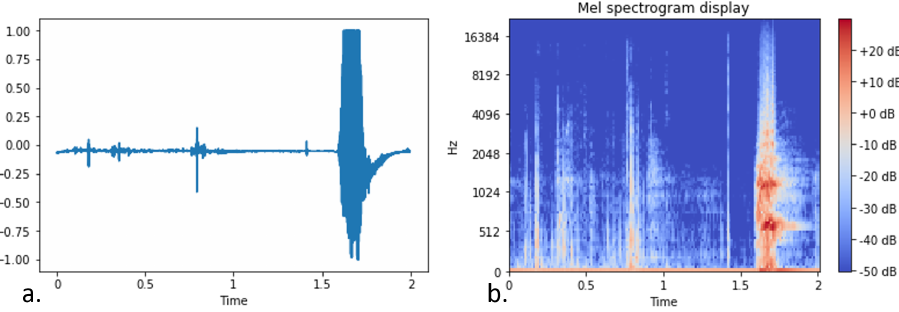
Figure 10. Raw representation ( a ) and log-scaled mel-spectrogram ( b ) of a dog barking audio signal.